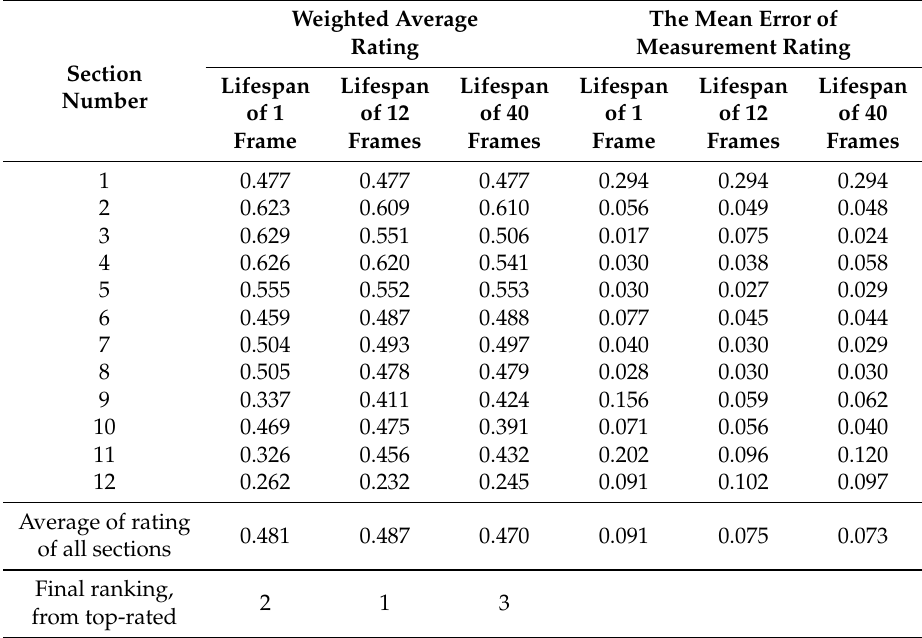
Table 4. The results of the weighted person detection assessment using Method